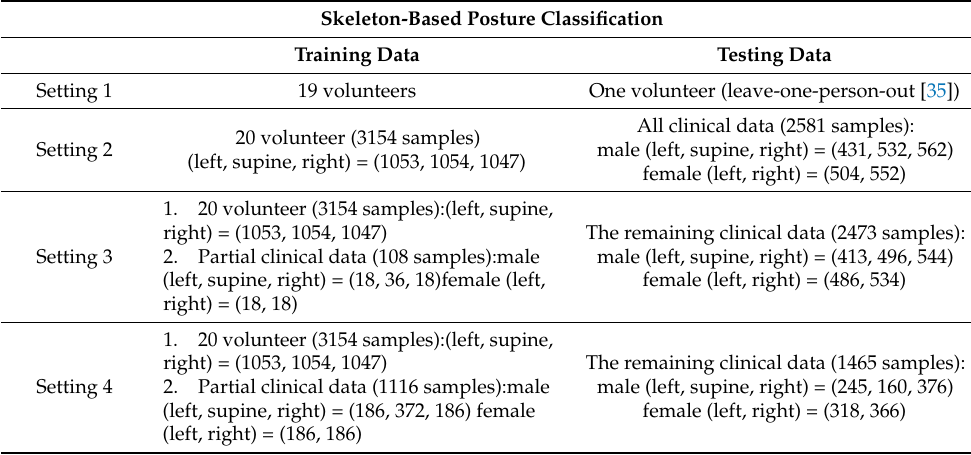
Table 3. Different Settings 1~7 for training and testing sets in our ablation